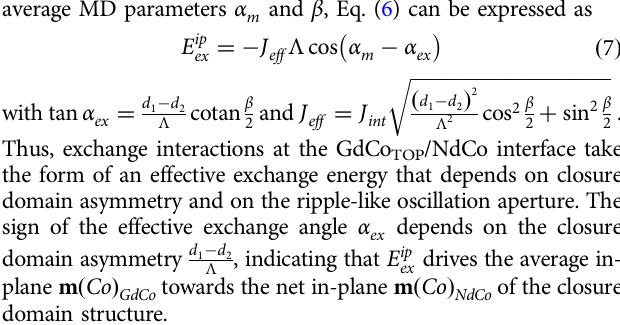
Fig. 4, as a function of α